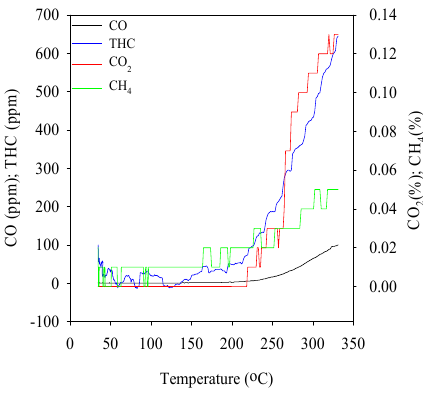
Figure 6. Changes of ( a ) H/C and ( b ) O/C molar ratios as a function of the torrefaction residence time.